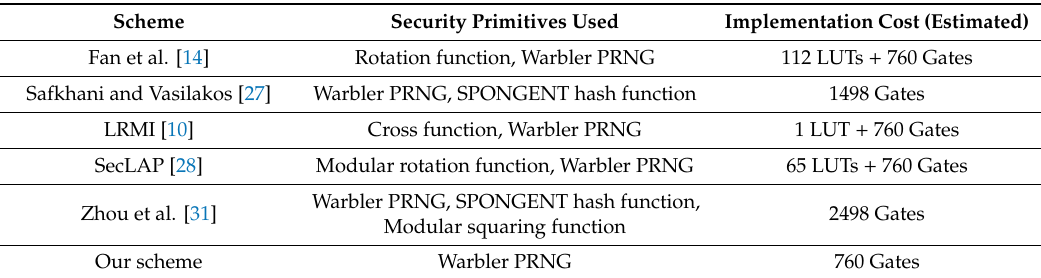
Table 8. Performance comparison based on the estimated hardware implementation cost.